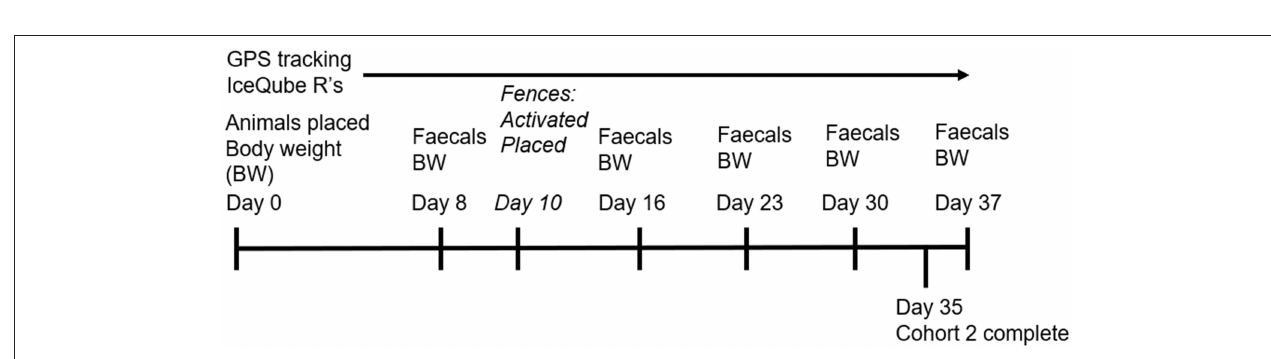
FIGURE 2 | A depiction of the experimental data collection timeline for cattle tested within two cohorts. NB: Cohort 2 finished 2 days earlier than cohort 1 due to neckband malfunction.